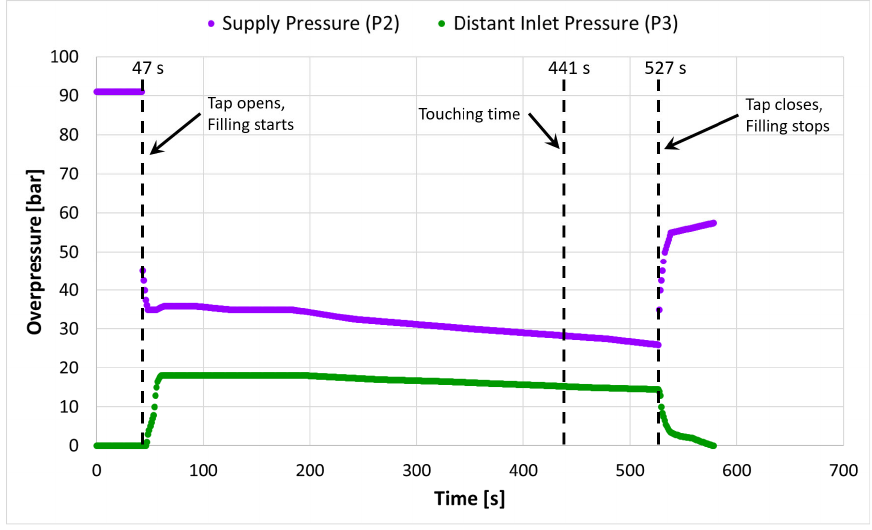
Figure 12. Supply pressure and distant inlet pressure pro fi les of a “Bo tt om” case measurement.